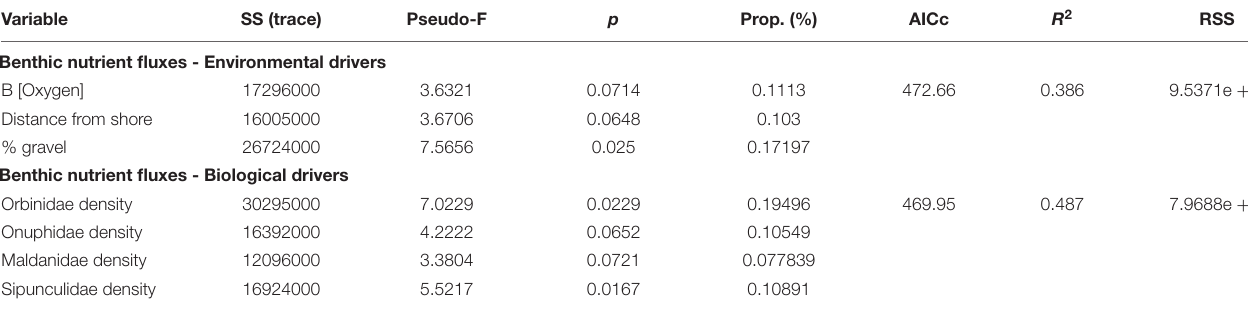
TABLE 5 | Statistical results of DistLM analysis for fitting environmental and biological factors to benthic nutrient fluxes. Variable